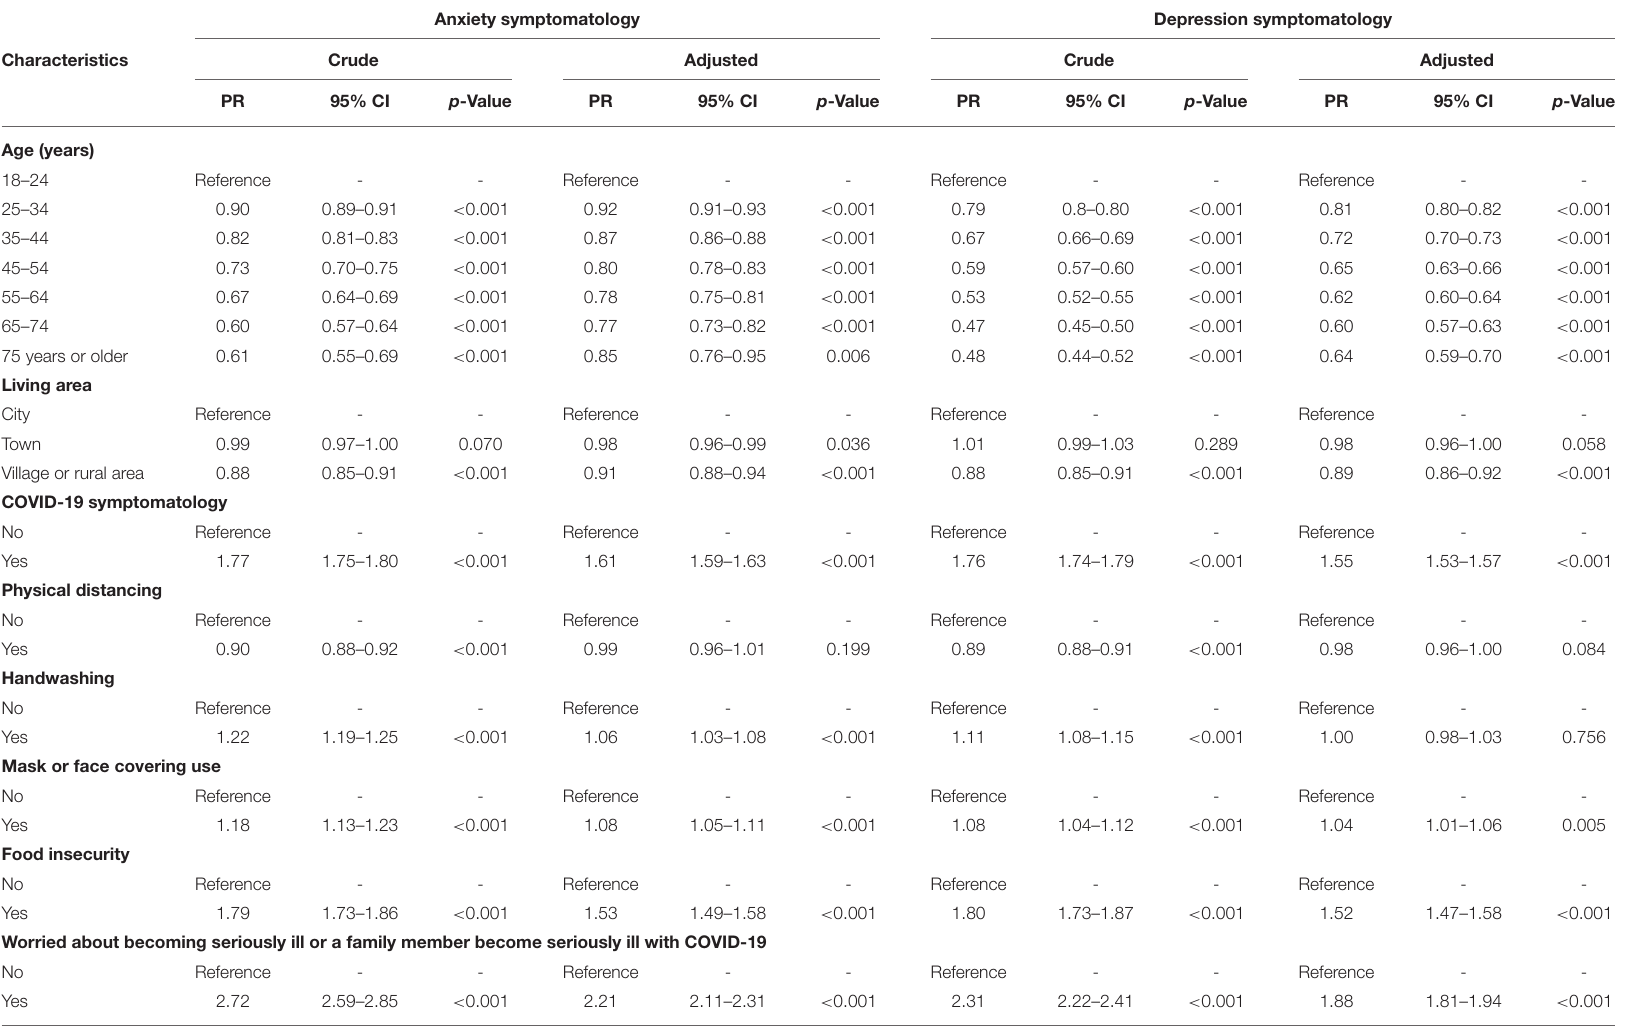
TABLE 4 | Crude and adjusted generalized linear models of Poisson family with logarithmic link to evaluate the factors associated with anxiety or depression in men